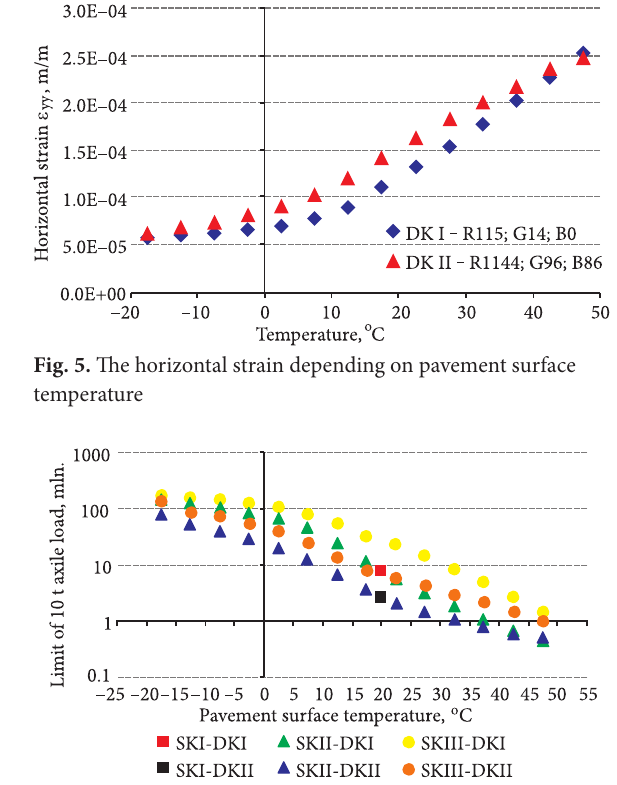
Fig. 6. The limit load according to asphalt base layer resistance to fatigue